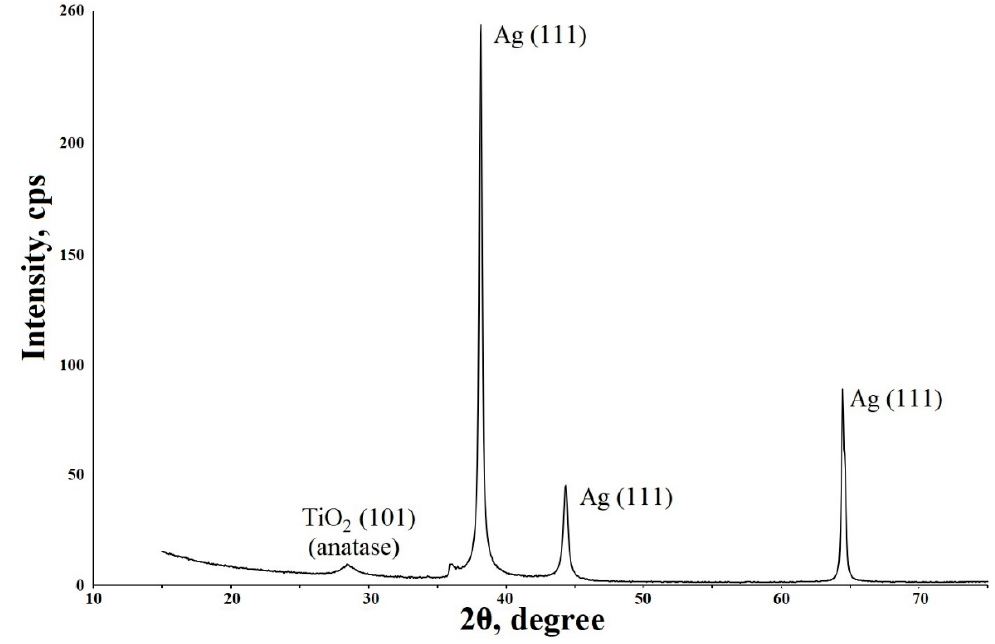
Figure 4. XRD patterns of the sample coated with TiO 2 /Ag.